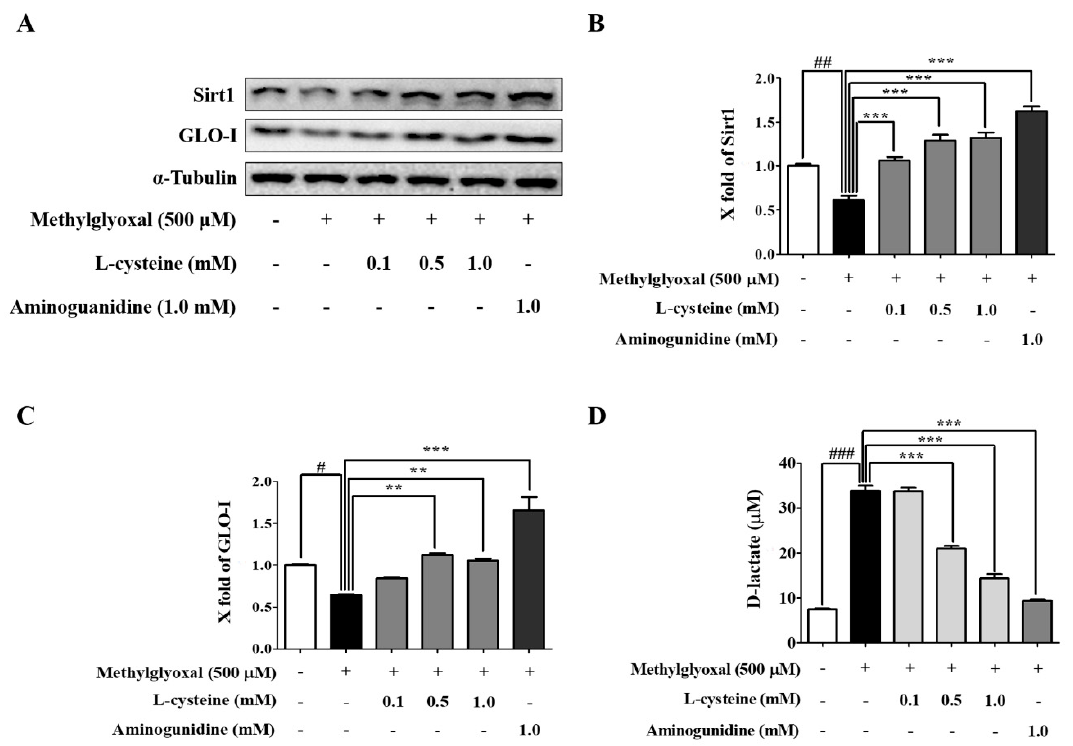
Figure 5. Effects of L -cysteine on glyoxalase system-related protein and D-lactate production in MGO-induced MES13. Cells were pretreated with L -cysteine (0.1, 0.5, and 1.0 mM) for 1 h, followed by incubation with 500 μ M MGO for 24 h. ( A ) The protein expression levels of Sirt1 and GLO-I were evaluated by western blot. ( B , C ) Sirt1 and GLO-I band intensity; α -tubulin was used as an internal control. ( D ) Quantitative levels of D-lactate were shown in MES13 cells. All data are presented as mean ± SEM. n = 3 (# p < 0.05, ## p < 0.01, ### p < 0.001 vs. Control, ** p < 0.01, *** p < 0.001 vs. MGO 500 μ M).